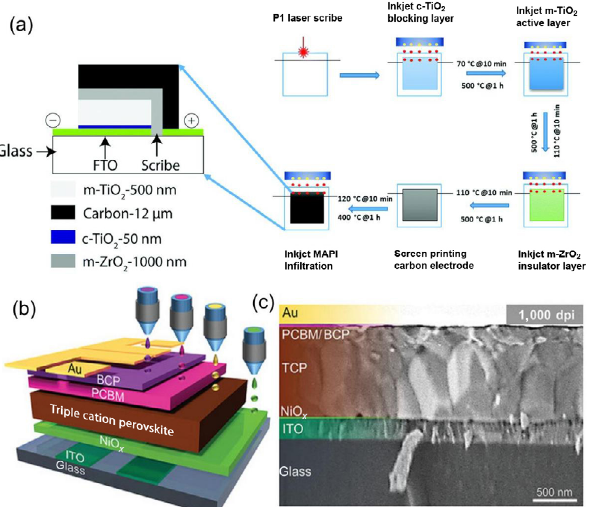
Figure 6 (a) Device architecture with desired layer thicknesses. Process flow demonstrating inkjet-printed compact TiO 2 layer, mesoporous TiO 2 layer, mesoporous ZrO 2 layer and infiltration of perovskite precursor. Yellow dots represent the print head nozzles while red dots represent the ejected droplets. Reproduced with permission from Ref. [55], © The Royal Society of Chemistry 2020. (b) Schematic of the device architecture with indium tin oxide (ITO), printed NiO x , perovskite, PCBM and BCP layers. (c) Cross-sectional SEM image of the device. Reproduced with permission from Ref. [56], © Schackmar, F., et al.